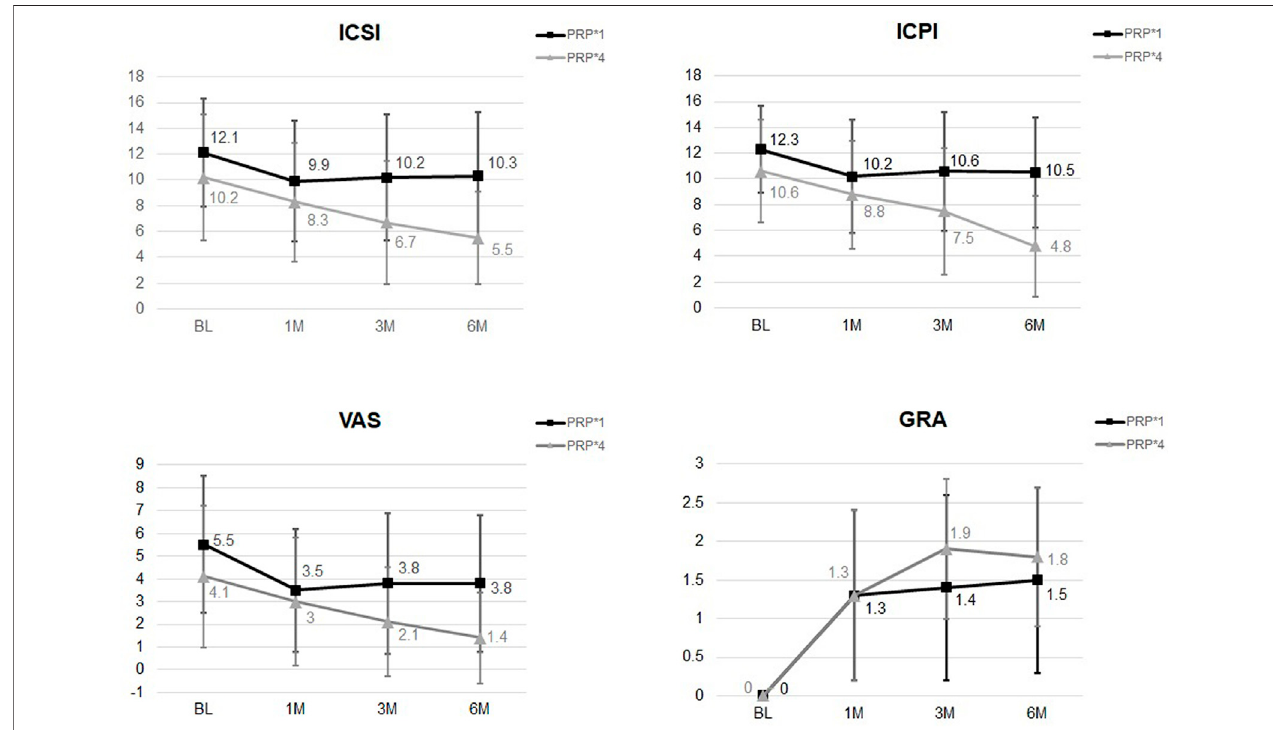
FIGURE 2 | The changes of ICSI, ICPI, VAS, and GRA after different PRP injection protocols. Signi fi cant difference was noted in ICSI and ICPI from baseline to 6 months between